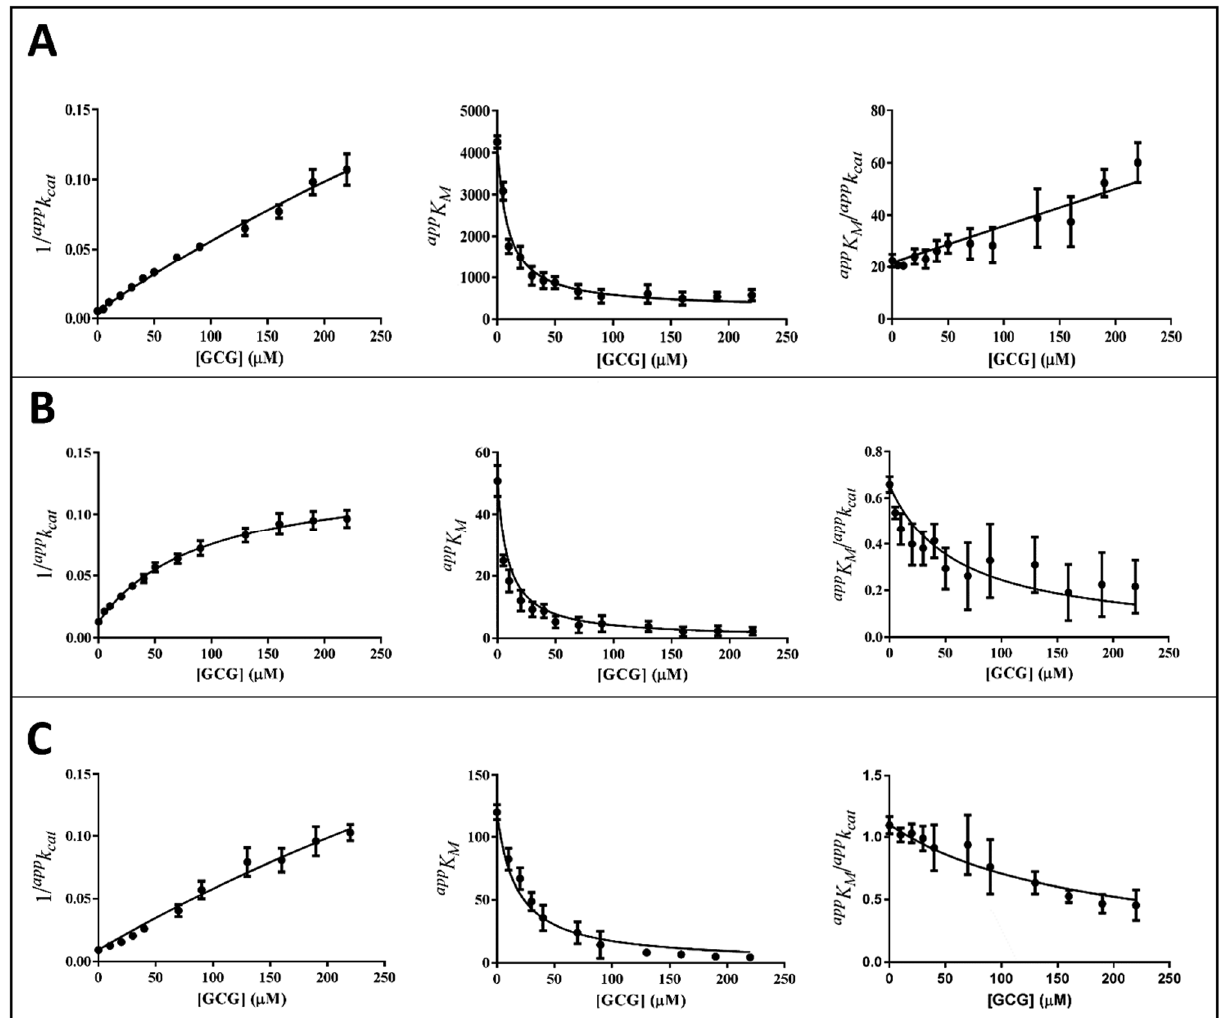
Figure 5. Kinetic analysis of GCG inhibition of the AKR1B1-dependent reduction of different sub- strates. Panel ( A – C ) refer to L-idose, HNE, and GSHNE, respectively. The secondary plots of apparent kinetic parameters at different [I] derived from the non-linear regression Michaelis–Menten analysis of primary kinetic data reported in Figure 3A. Bars (when not visible are within the symbols size) represent the standard error of the measurements. The parameters 1/ app k cat , app K M , and app K M / app k cat versus [I] were interpolated by non-linear regression using Graphpad Software 7.04. See the text for details.